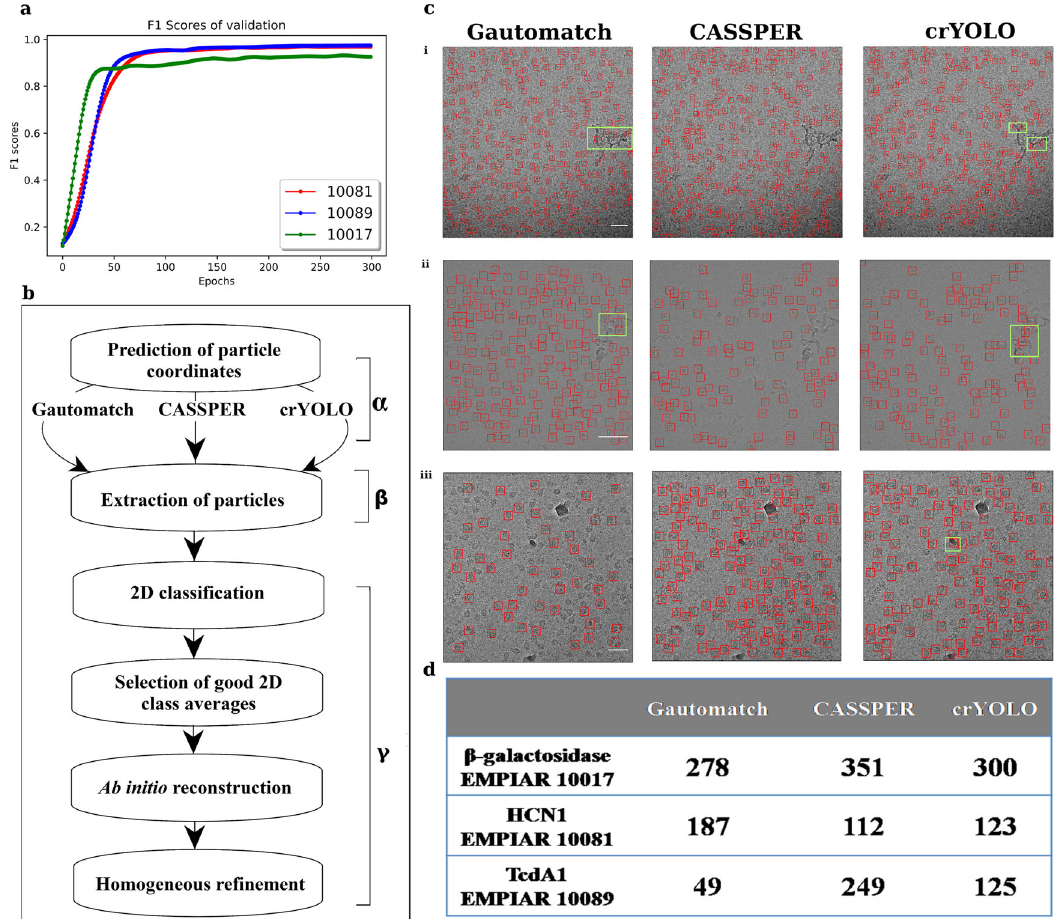
Fig. 3 Training and picking by CASSPER and comparison with other tools. a The validation F1 scores, which are used to select the best trained model in training epochs for prediction, for all three proteins. b Schematic representation of the uniform pipeline used to compare the performance of Gautomatch, CASSPER, and crYOLO. c Representative micrographs (scale bar, 50 nm) for (i) β -galactosidase, (ii) HCN1, and (iii) TcdA1 showing the particle picking performance of different tools. Highlighted areas indicate the noise picked by the respective tools. d Table showing the number of particles picked by Gautomatch, CASSPER, and crYOLO on the same micrograph for each protein as shown in c